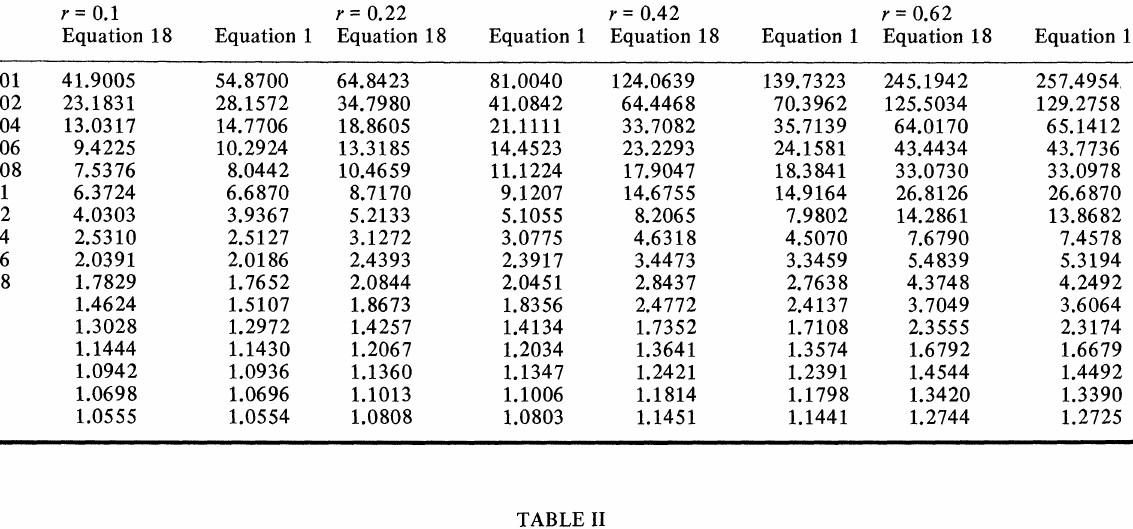
TABLE II Thin monocrystalline films: comparison of the values of the resistivity ratio/9F//9o as given by the equations indicated for the case of partially specular scattering on external surfaces:/9 0.5 r=0.1 r=